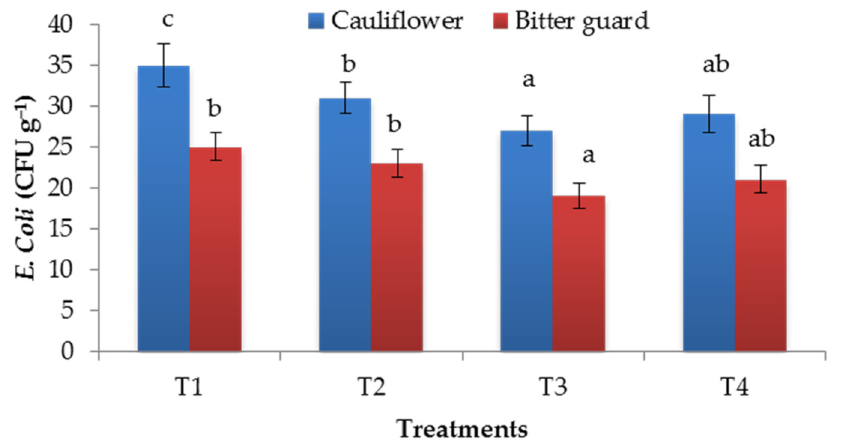
Figure 6. Incidence of E. coli in cauliflower curd and bitter gourd fruit under di ff erent treatments. Vertical bars for each column represent standard deviation ( n = 3) of the mean. Means of di ff erent treatments followed by the di ff erent lowercase letter (a,b) are significantly di ff erent ( p < 0.05) within the same crop.